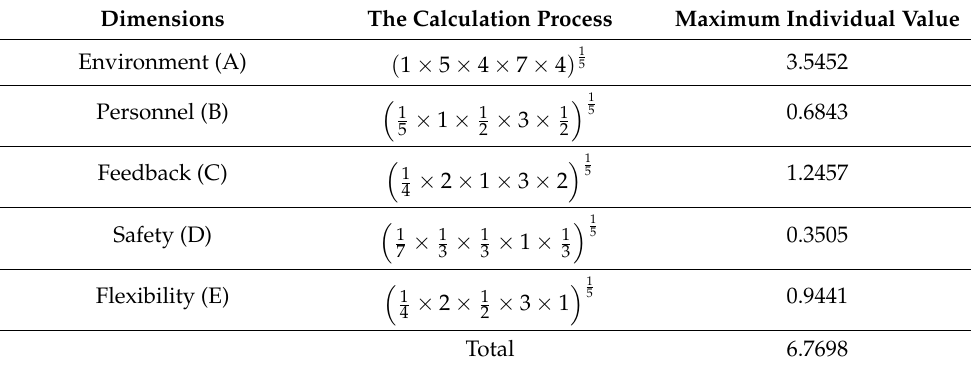
Table 5. The maximum individual value calculation